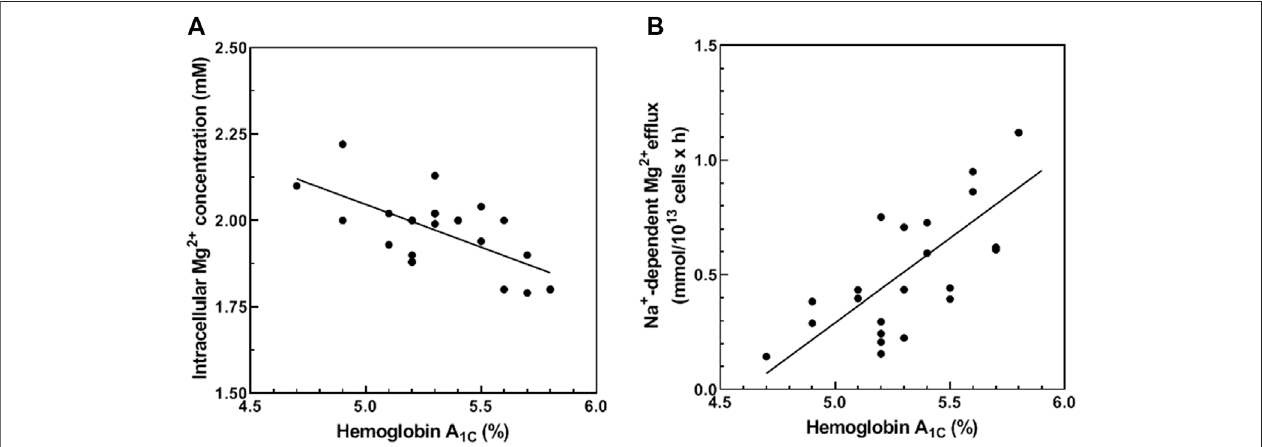
FIGURE1| CorrelationbetweenHbA 1C andtotalcellularMg 2+ content (A) andNa + -dependentMg 2+ ef fl ux. (A) Cellsfrom23normalsubjectswereassayedforhemoglobin A 1C (HbA 1C )andtotalcellularMg 2+ contentasdescribedinMethods.ThegraphrepresentstotalcellularMg 2+ contentvs.HbA 1C ( n =23,r= − 0.600and p < 0.01; σ = − 0.491and p < 0.05). (B) Cells from 23 normal subjects were assayed for HbA 1C and Na + -dependent Mg 2+ ef fl ux (Na + /Mg 2+ exchanger activity) as described in Methods. The graph represents Na + /Mg 2+ exchanger activity vs. HbA 1C ( n = 23, p < 0.001 and r = 0.716 and p < 0.001; σ = 695 and p < 0.001).